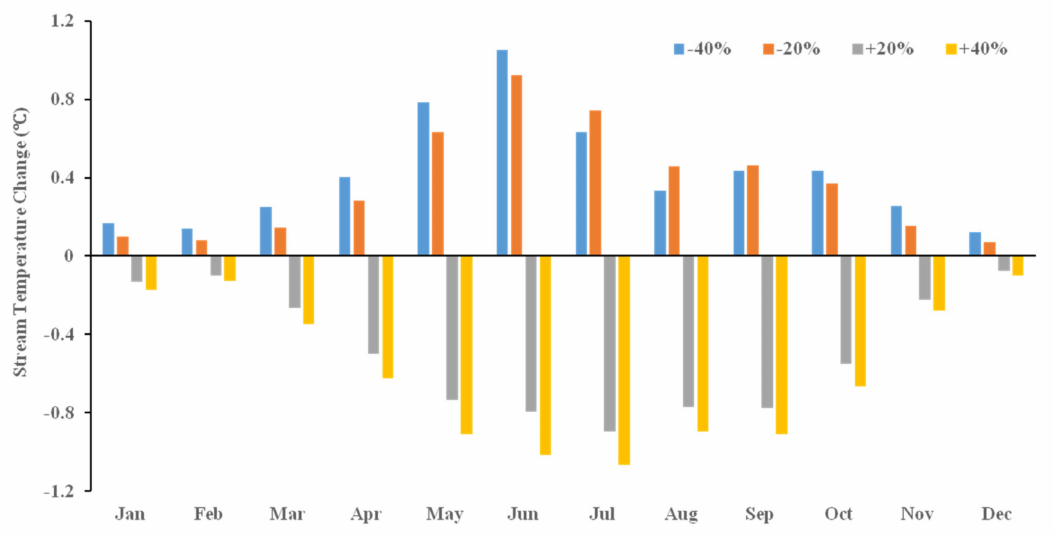
Figure 5. Stream temperature sensitivity to streamflow changes in the